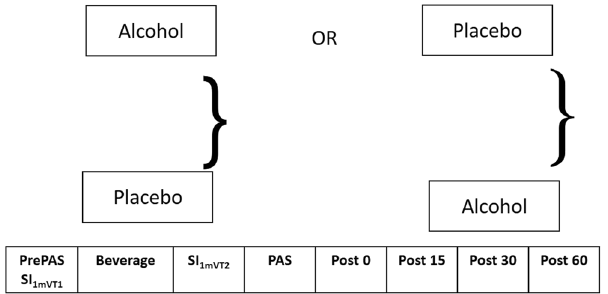
Figure 1. Study design. Study visits (alcohol/placebo) were randomized with a 1 month washout period between study visits. 100 TMS pulses were administered to the DLPFC at 1 mV stimulus intensity prior to beverage consumption (SI 1mVT1 ). Subjects were given 15 minutes to consume the beverage. BAC was obtained every 15 minutes following beverage consumption (except during PAS). Another 100 TMS pulses were administered following beverage consumption and stimulus intensity was adjusted if necessary (SI 1mVT2 ). PAS was then administered using SI 1mVT2 , followed by 100 TMS pulses also at SI 1mVT2 at Post 0 (immediately following PAS), Post 15 (15 minutes following PAS), Post 30 (30 minutes following PAS) and Post 60 (60 minutes following PAS). EEG was collected at all time points to measure